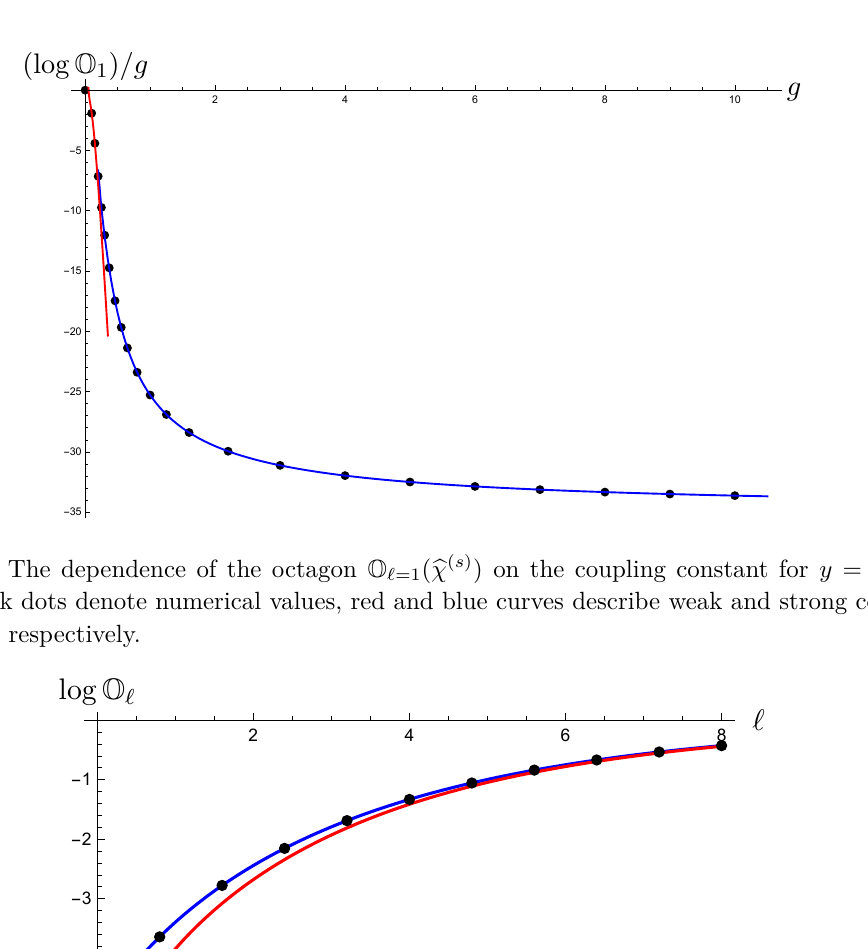
Figure 3 . The dependence of the octagon O ‘ ( χ ( s ) ) on the bridge length ‘ for g = 2 and y = ξ = 0 . b Comparison of numerical values (black dots) with large g expansion (6.1) (blue curve) and large ‘ expansion (7.14) (red curve). The two curves merge at ‘ ≈ 5 , or equivalently ¯ ‘ ≈ 1 . 25 . Large bridge length